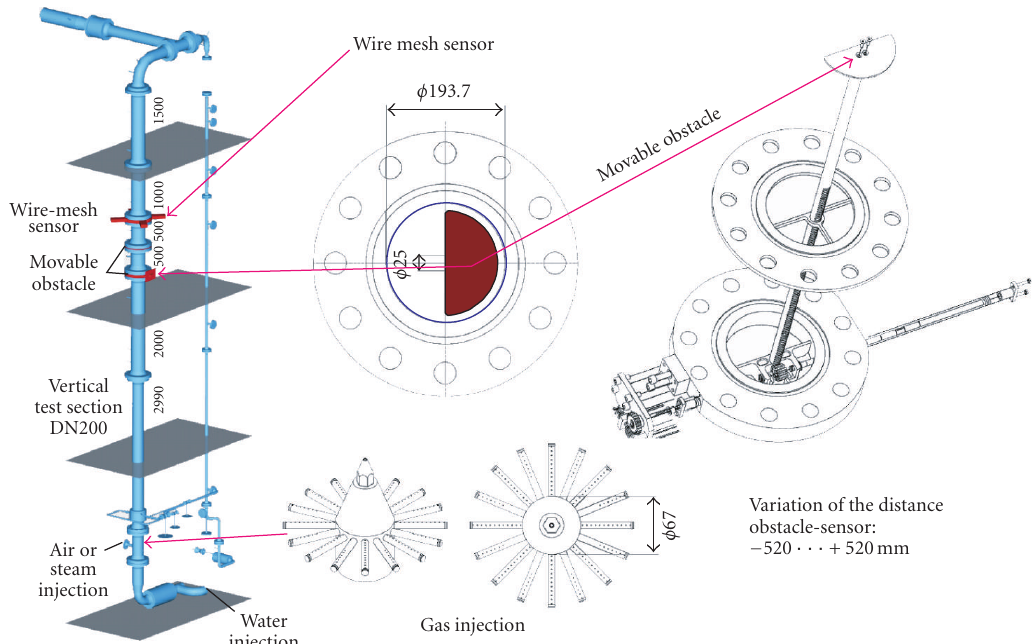
Figure 3: Sketch of the movable obstacle with driving mechanism—a half-moon shaped horizontal plate mounted on top of a toothed rod.